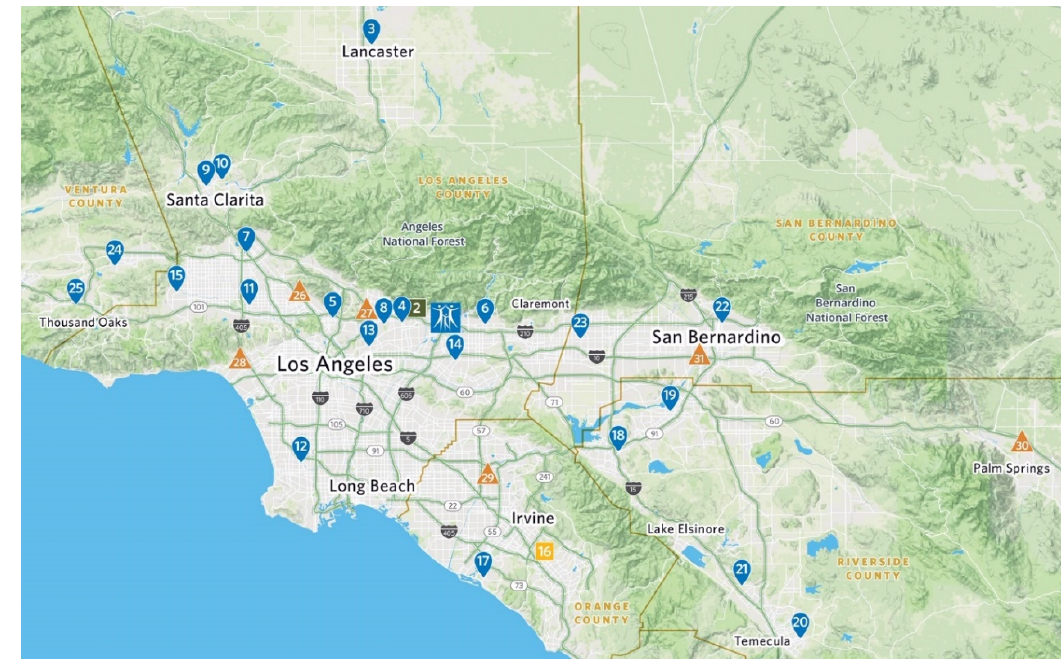
Figure 1. Map of City of Hope Locations in Southern California. Blue Square, Duarte National Medical Center Academic Site; Blue Teardrops, Community Cancer Center Practice Sites; Orange Triangles, City of Hope Oncologist-Staffed Community Hospitals; Yellow Square, Orange County Campus (under construction). Map designed at City of Hope Medical Center.